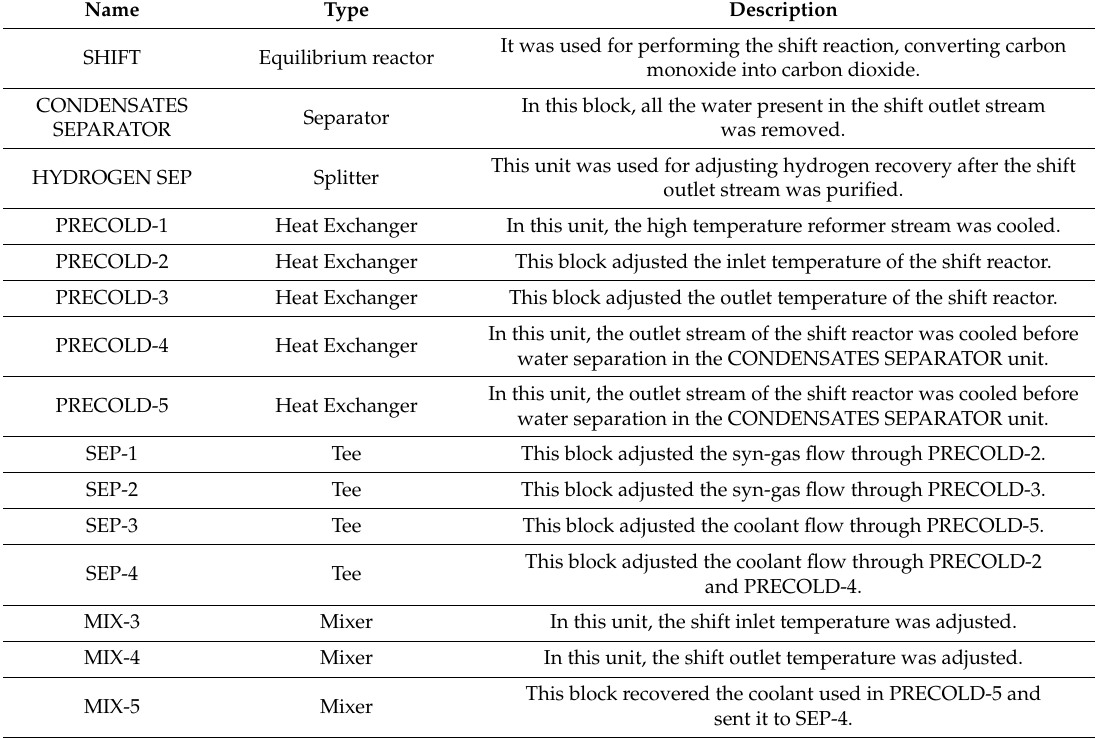
Table 4. Description of the blocks used in Section